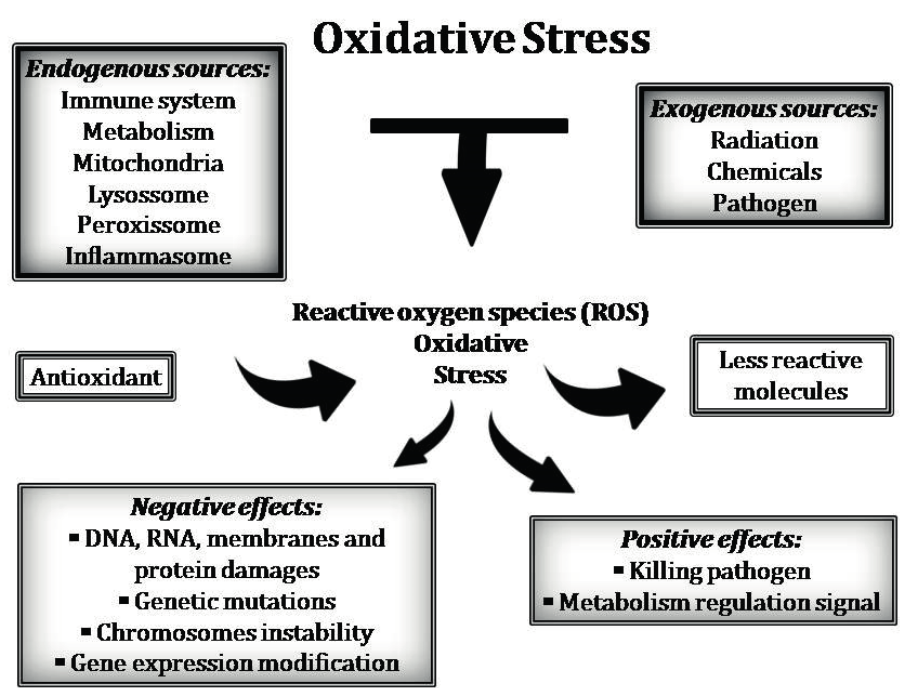
Figure 1 - The concept of the oxidative stress